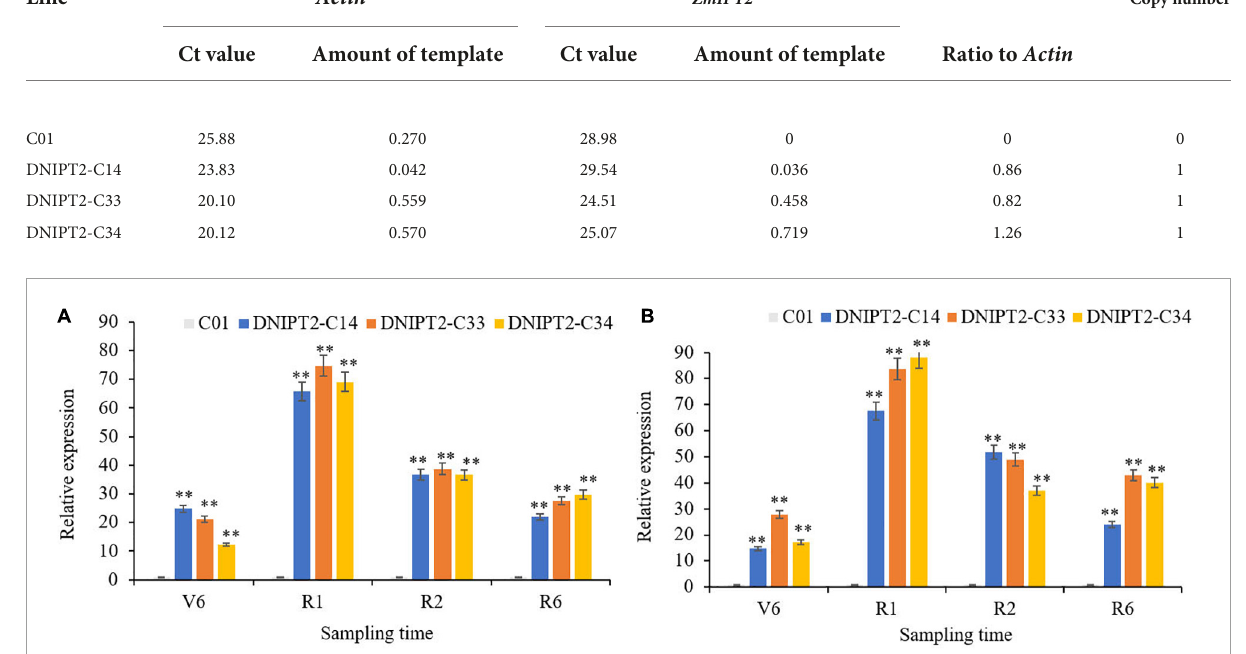
FIGURE2 Relative expression levels of transgenic ZmIPT2 gene in maize leaves at different stages in T2 and T3 generation. (A) Shows Relative expression levels of transgenic ZmIPT2 gene in maize leaves at different stages in T2 generation, V6 (sixth leaf), R1 (silking), R2 (blister stage) and R6 (physical maturity); (B) shows Relative expression levels of transgenic ZmIPT2 gene in maize leaves at different stages in T3 generation. The error bars denote standard deviations of the qRT-PCR signals ( n = 3). There was significant difference or extremely significant difference in the expression level of ZmIPT2 (** P < 0.01, Student t